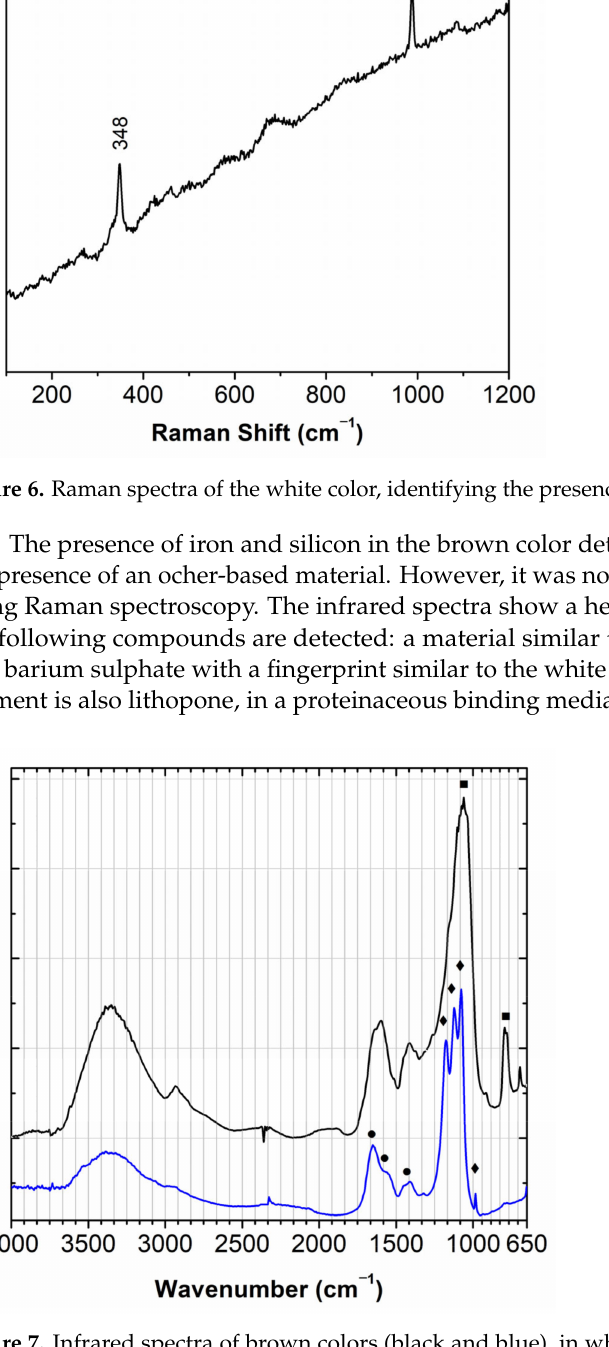
Figure 7. Infrared spectra of brown colors (black and blue), in which the main bands detected are assigned to quartz ( (cid:4) ), barium sulfate ( (cid:7) ) and a proteinaceous binder ( • ). Part of the white color from the “bigger” porcini was covered with a varnish, Figure 8. This varnish was micro-sampled and its spectra revealed the fingerprint of a siccative oil; in Figure 8 it is compared with a linseed oil reference (unaged). It is possible that the lead observed in the XRF data is present in the varnish to catalyze the molecular drying of the